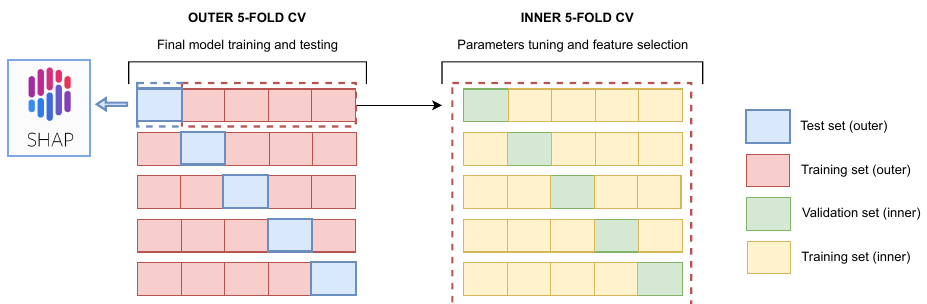
Figure 5. Schema of experimental setup, showing a schematic representation of the nested cross validation in the outer loop on the left and the inner loop on the right. Each row on the left represents the whole dataset, which is divided in five different folds; one fold (blue) is used as an independent test set, while the remaining four folds form the training set. Repeating this split five times ensures that each single fold is considered as a test set once. In the inner loop on the right, the training set is subsequently split in five folds again in order to obtain a validation set (green) used to estimate the model’s performance during the grid search and feature selection procedure. The best model with the chosen parameters and features is then retrained on the outer training set (red) and tested on the outer test set (blue). SHAP values for the final model interpretability are computed on the test